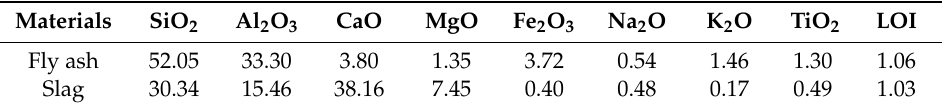
Table 1. Chemical compositions of fly ash and slag as measured by X-ray fluorescence (XRF) (wt.%). Loss on ignition at 1000 ◦ C represented by